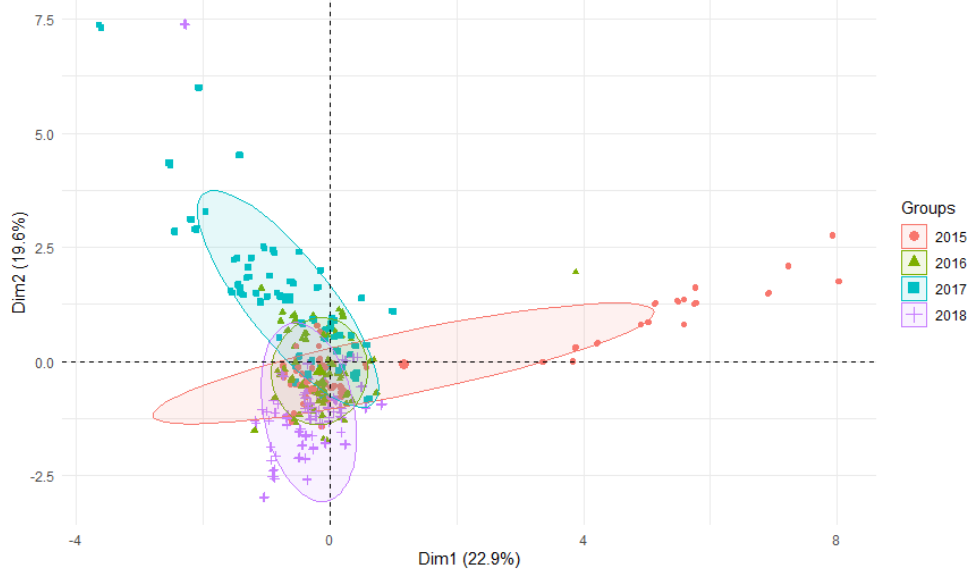
Figure 2. PCA plot 2D showing clustering of Al concentration in plants from rivers across 29 sites and 4 years (2015–2018).